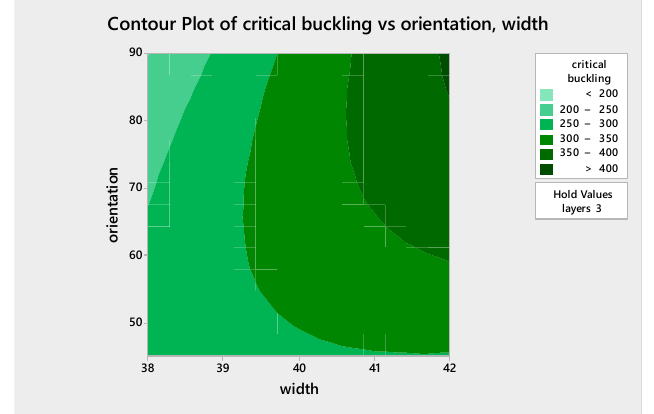
Figure 11. Contour plot of critical buckling versus orientation, width. Contour Plot of critical buckling vs width, layers